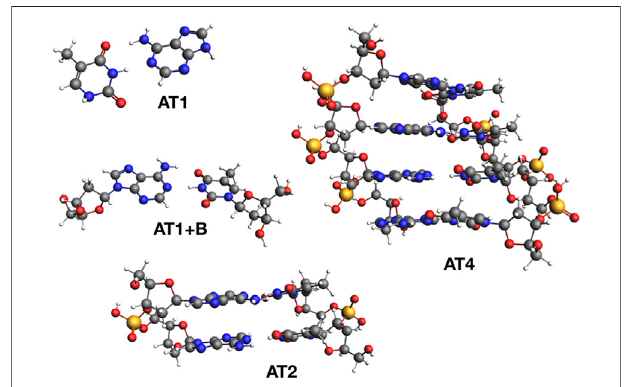
FIGURE 5 | DNA model systems used in this